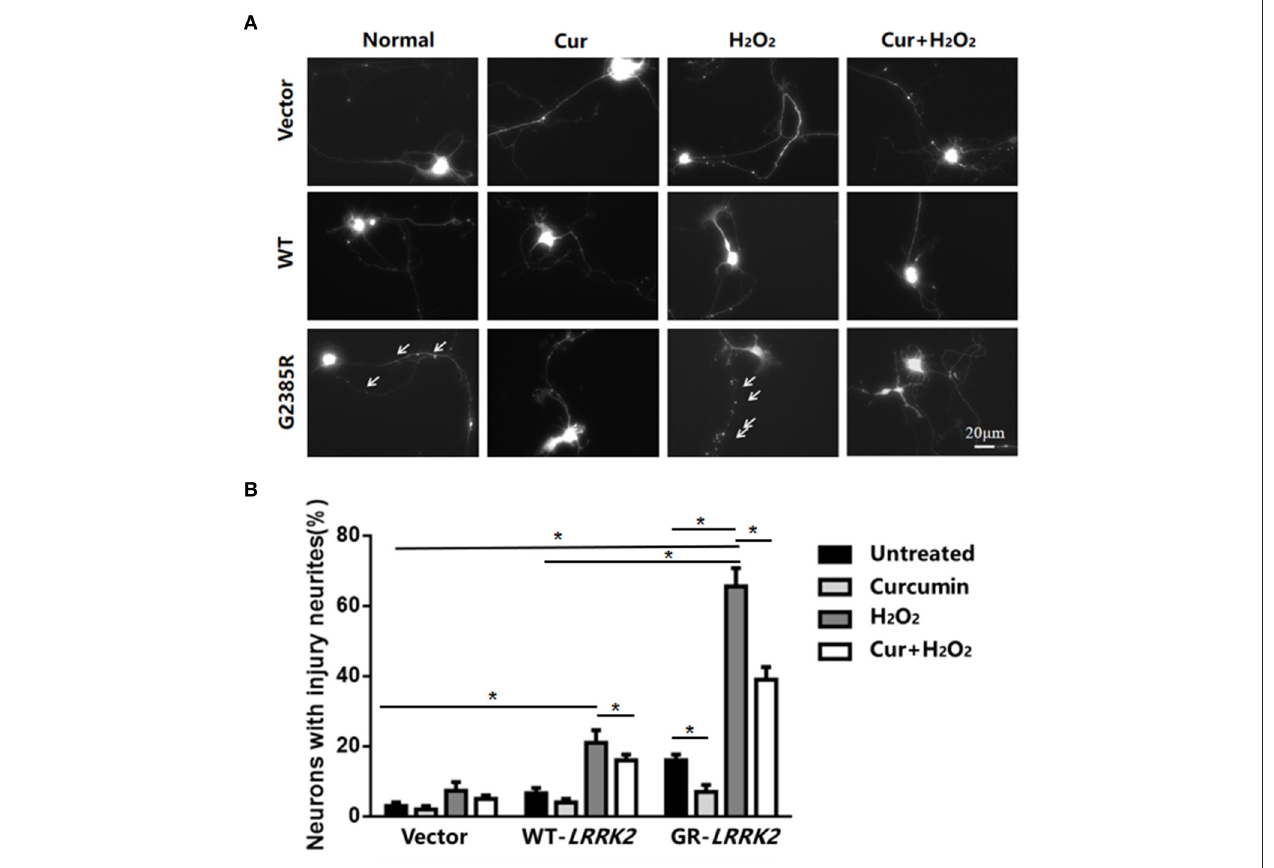
FIGURE 4 | Curcumin protects against combined neurotoxicity of G2385R-LRRK2 and subtoxic H 2 O 2 . Mouse cortical primary neurons were co-transfected with GFP and vector or various LRRK2 constructs at 1:10 ratio, with or without a subtoxic dose of H 2 O 2 exposure and curcumin (1 µ M). Neurons with injured neurites were measured. (A) Representative fluorescent images of neurons in each group. (B) Neurons with injury (white arrow) were counted in each group. * p < 0.05, statistical significance between groups as